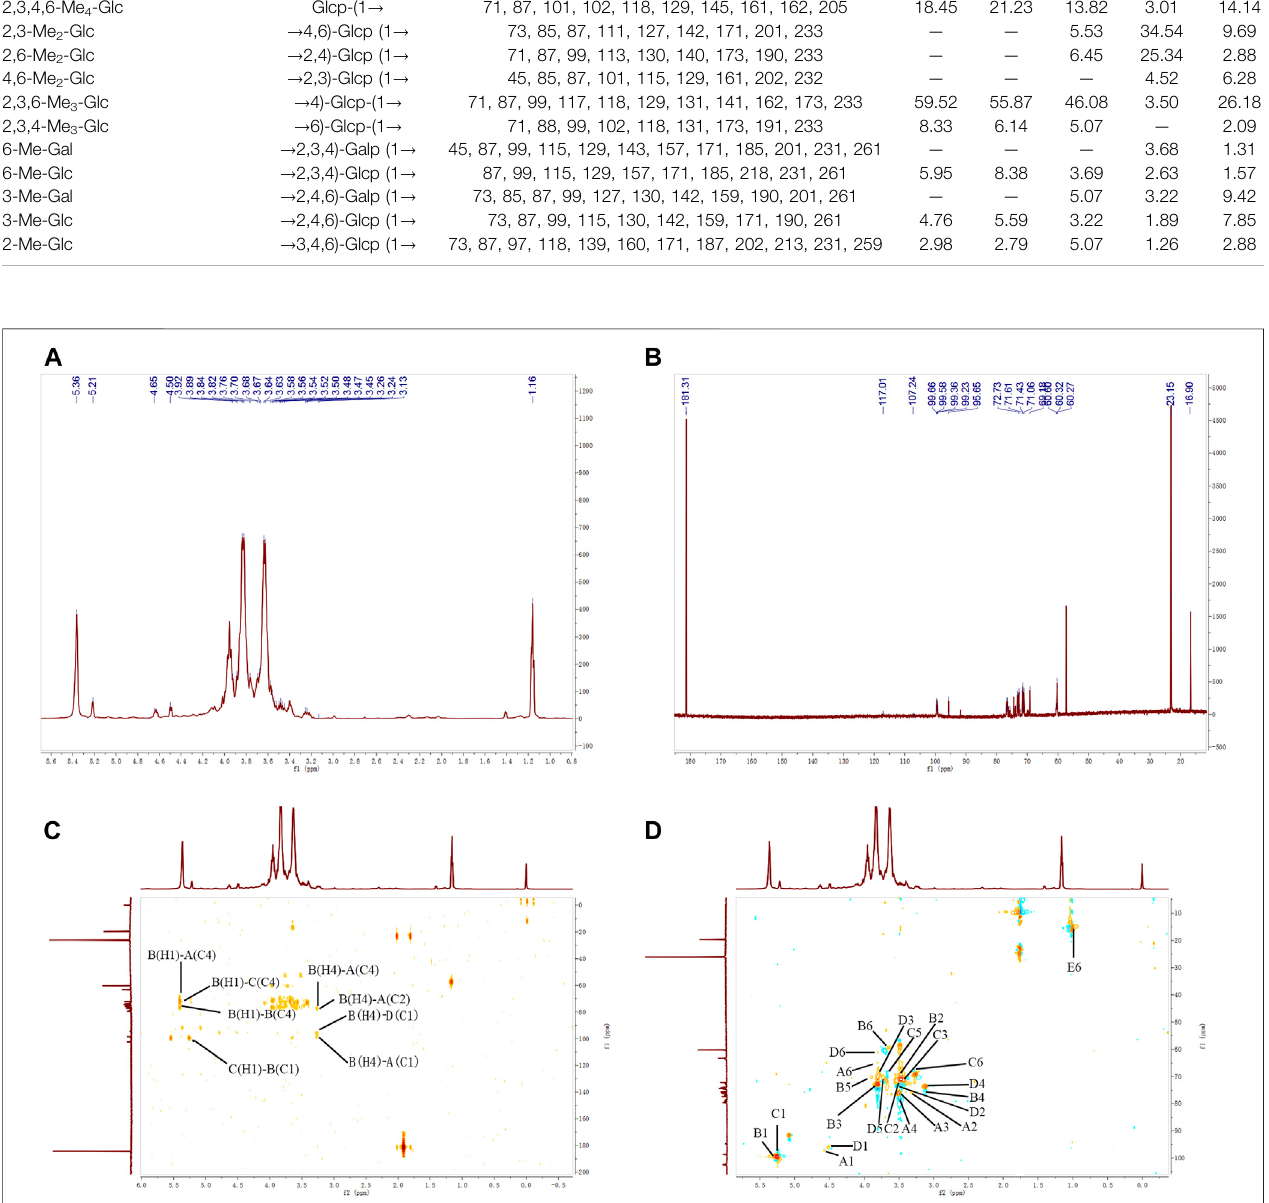
Frontiers in Pharmacology |